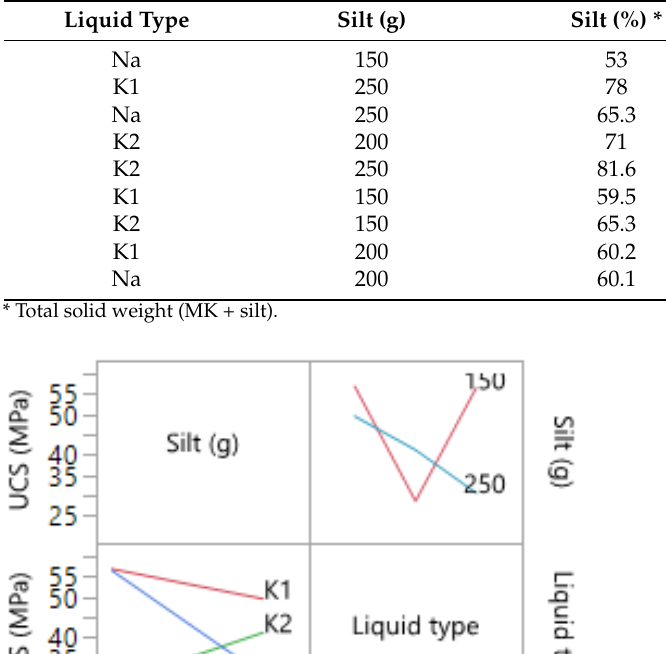
Table 12. UCS for samples produced with different amount of silt and liquid type.